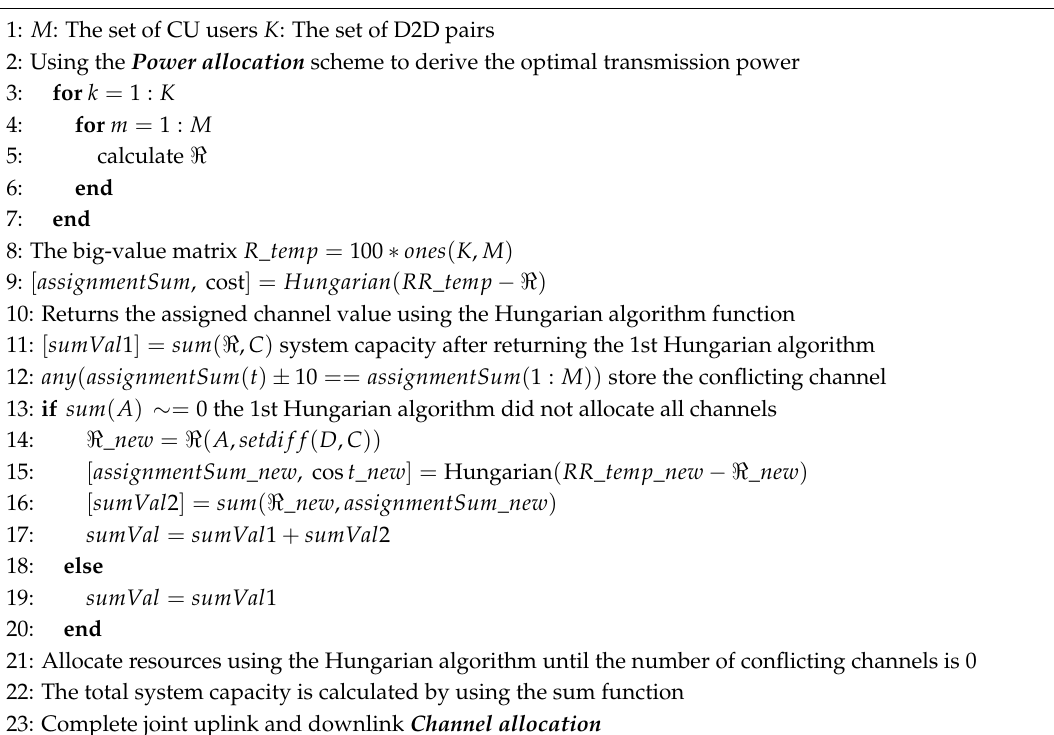
Algorithm 1. Optimal Resource Hungarian